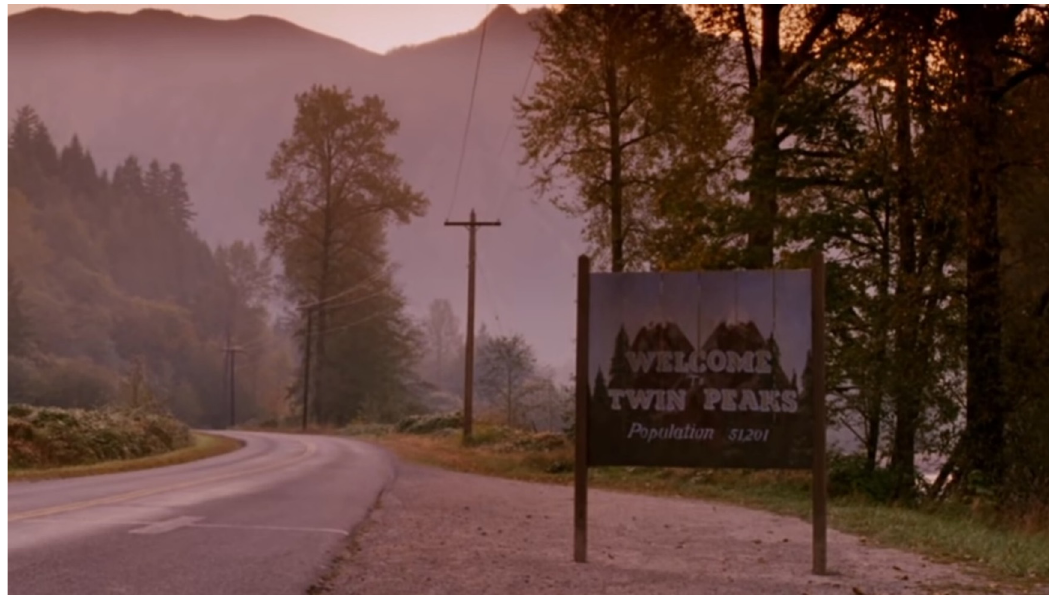
Figure 2: Still from Twin Peaks | Coming to Showtime video tweeted by Lynch and